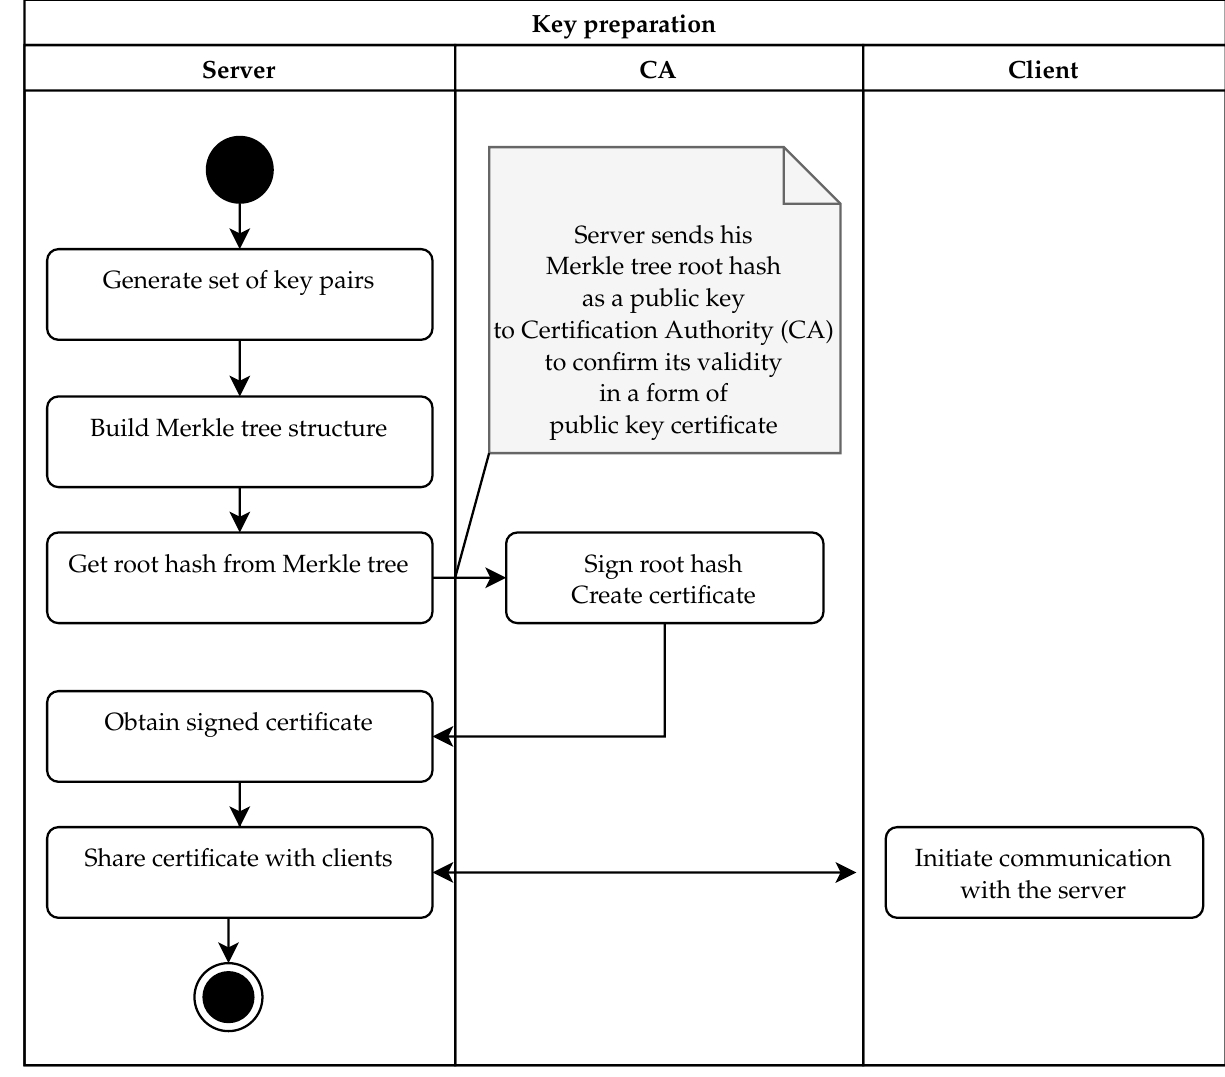
Figure 4. Preparation of keys on the server side